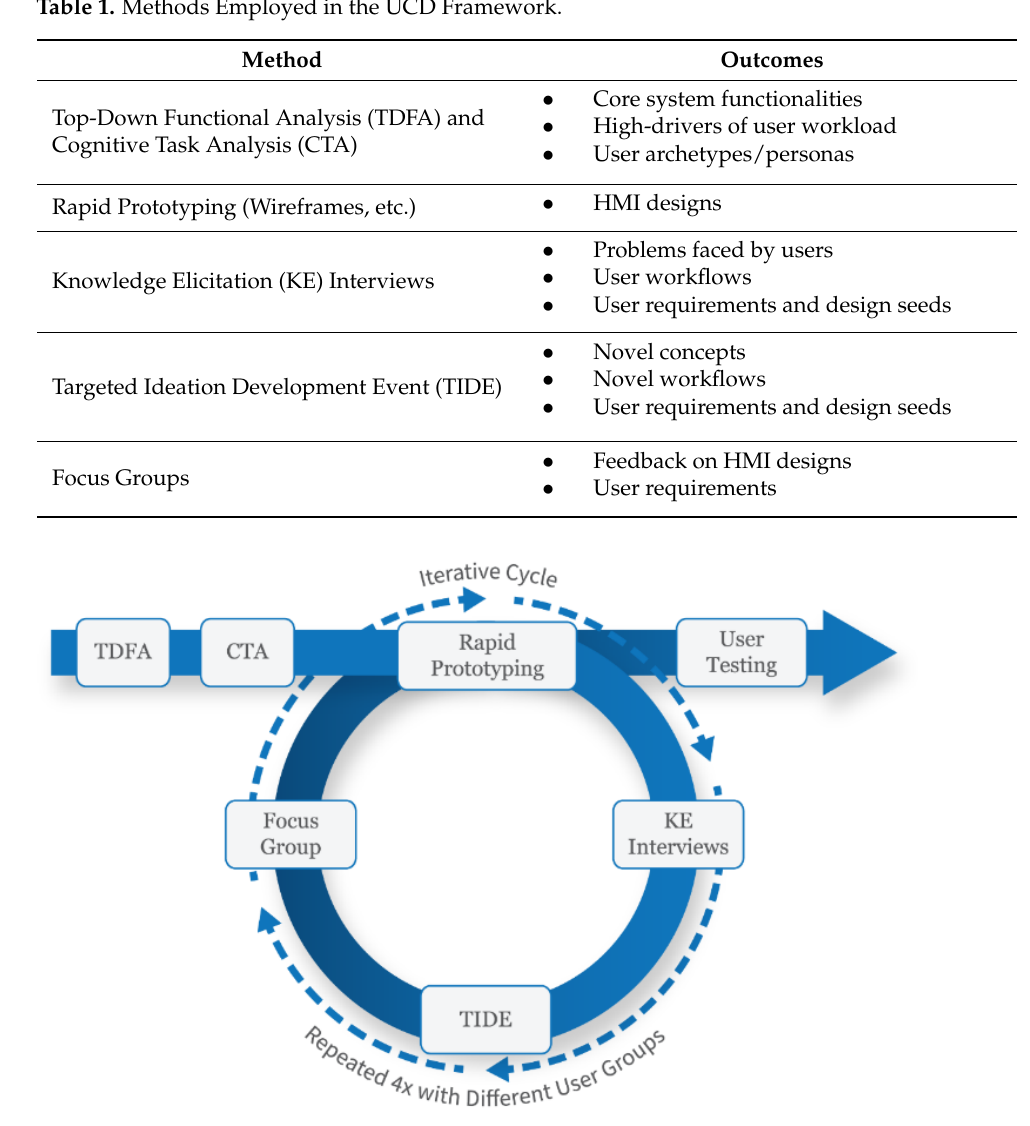
Figure 1. Iterative UCD Framework.